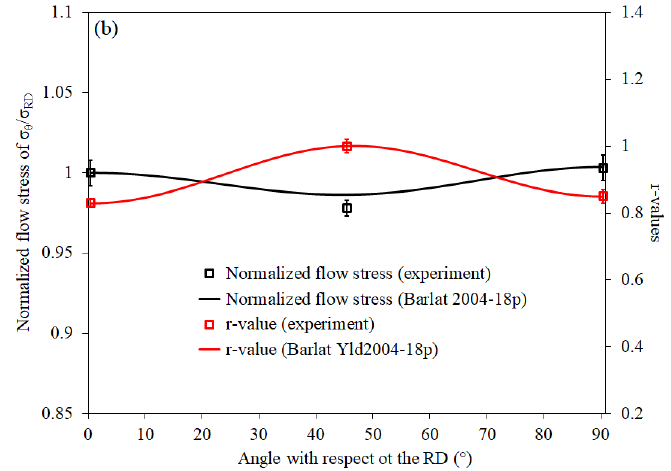
Figure A2. ( a ) The Barlat Yld2004-18p yield surface of the 25 °C die-quenched condition of Ductibor ® 1000-AS and ( b ) the predicted trends for the stress ratio and r-value in terms of the material orientation relative to the RD. The standard deviation of the measured data is denoted by the error bars.